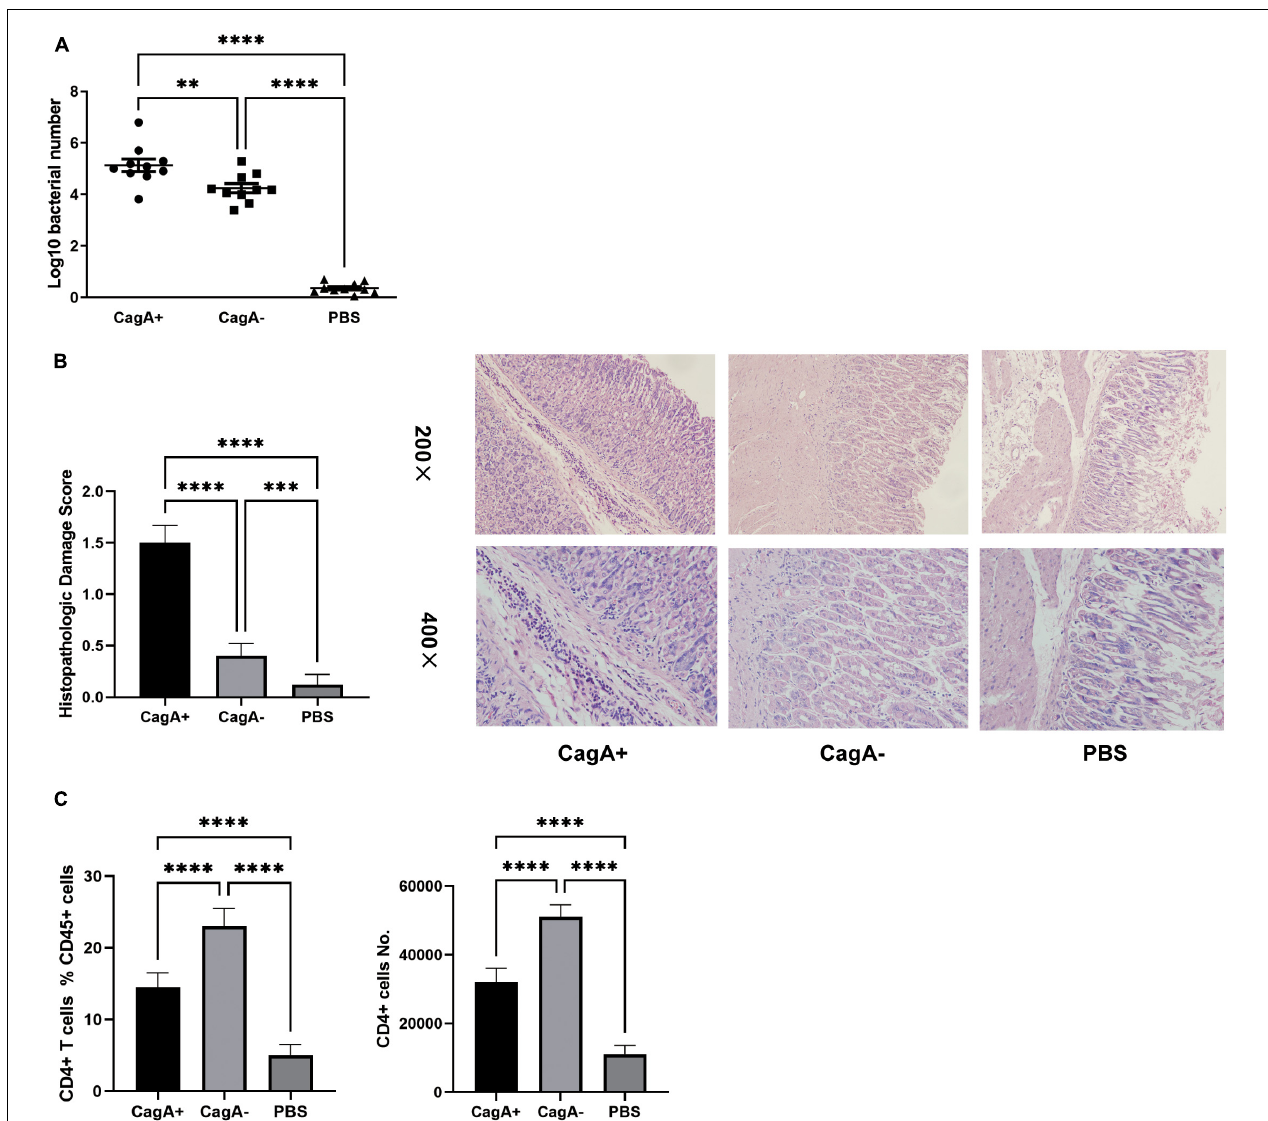
FIGURE 1 | CagA + H. pylori induced stronger inflammation but less mucosal CD4 + T cell formation than CagA − strain. Six- to eight-weeks old mice were infected with H. pylori strain NCTC11637 (CagA + ) or its isogenic mutant (cid:49) cagA NCTC11637 (CagA − ) via intragastric administration with 10 9 colony-forming units (CFUs) per mouse once daily for 4 days. In the control group, PBS was used instead of H. pylori. (A) Four weeks later, H. pylori colonization in the stomachs were detected by quantitative real-time PCR. (B) Mice stomach histopathologic damage score and representative histological images are shown. (C) The percentage and number of mucosal CD4 + T cells were measured by flow cytometry. Data are shown as mean ± SD. N = 10. ∗∗ p < 0.01, ∗∗∗ p < 0.001, and ∗∗∗∗ p < 0.0001. Results are representative of three individual